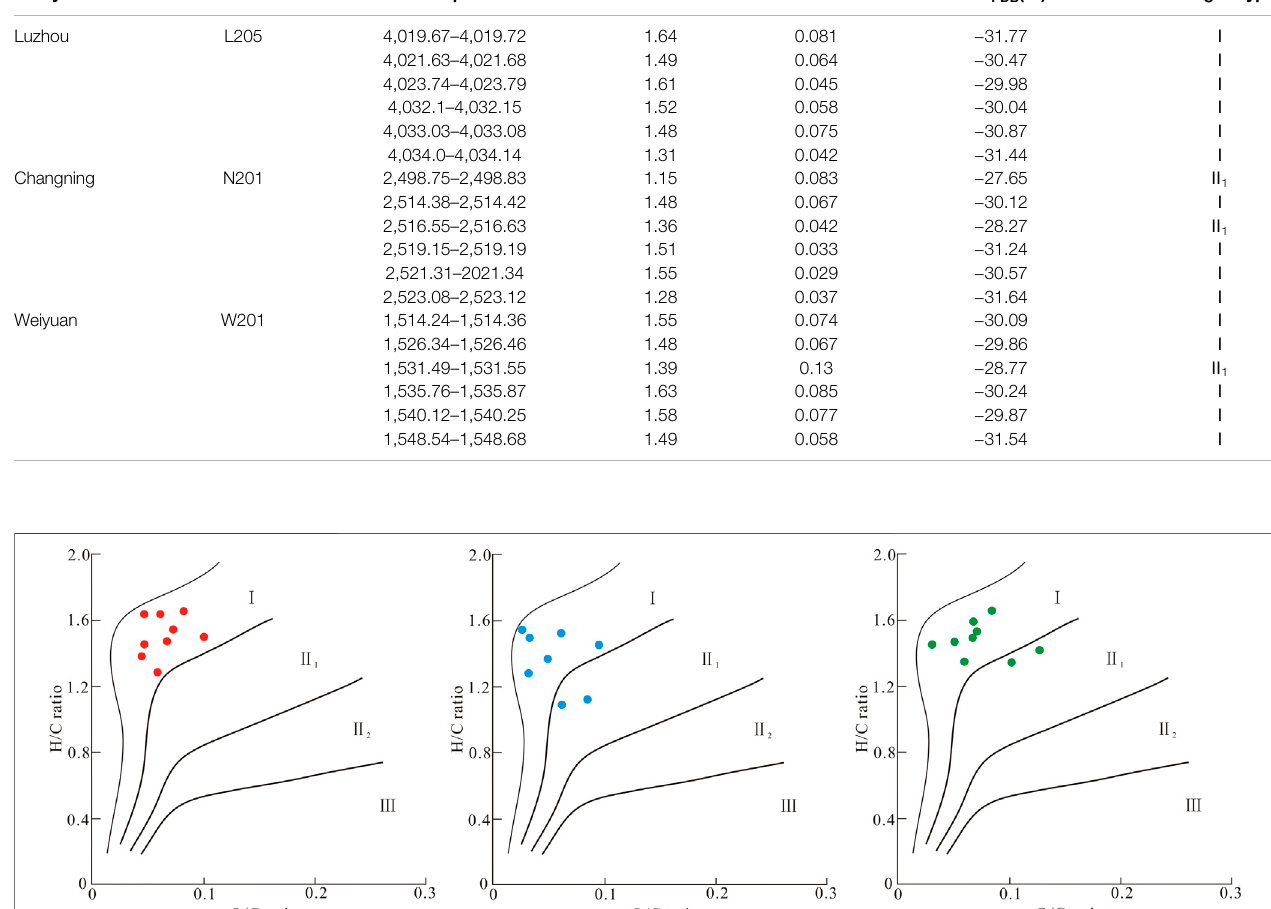
TABLE 2 | Isotopic analysis of shale kerogen in the Wufeng-Longmaxi Formations in the Weiyuan, Luzhou, and Changning areas. All experiments were performed at room temperature (26.5 ± 1 ° C). Study area Well